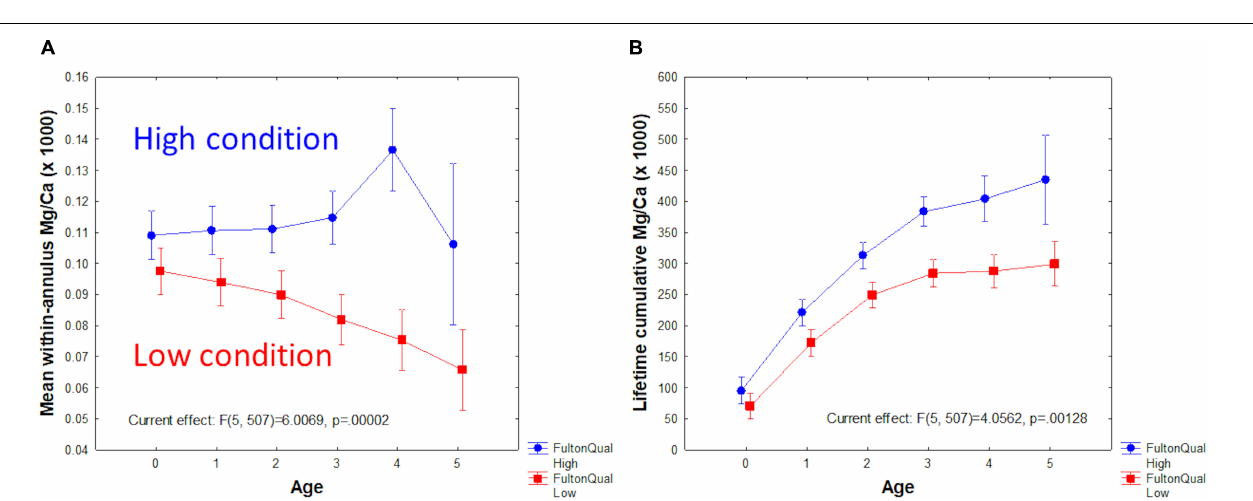
FIGURE 6 | Mg/Ca as a function of Fulton condition group (low < 9; high ≥ 9) and age. (A) Mean within-year Mg/Ca. (B) Lifetime accumulative